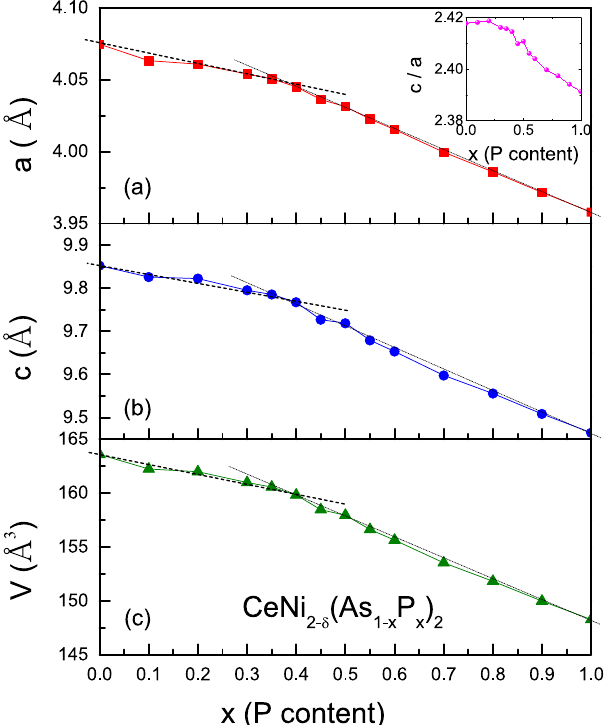
Figure 1. Lattice parameters a , c and unit-cell volume V as a function of the P content x in ( a – c ). The dashed and dotted lines are linear fit for x = 0.0–0.4 and 0.5–1.0, respectively. Inset to ( a ) shows the ratio of c / a